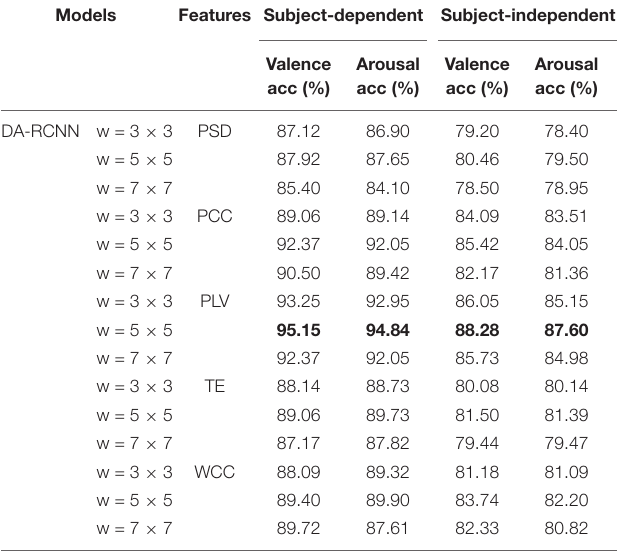
TABLE 5 | Overall performance of the proposed DA-RCNN model on different features.